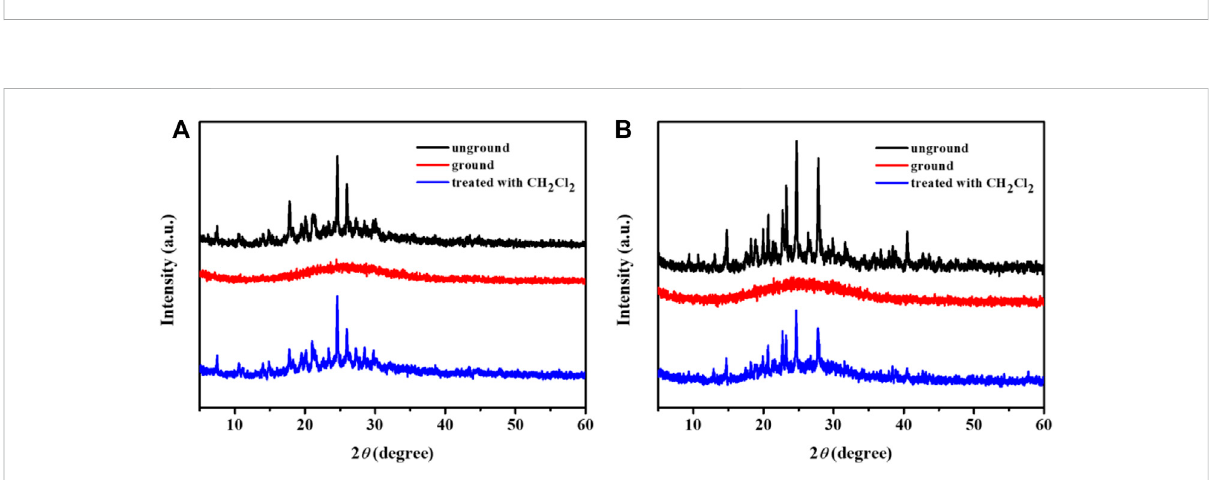
FIGURE 6 PXRD patterns of 1 (A) and 3 (B) in various solid